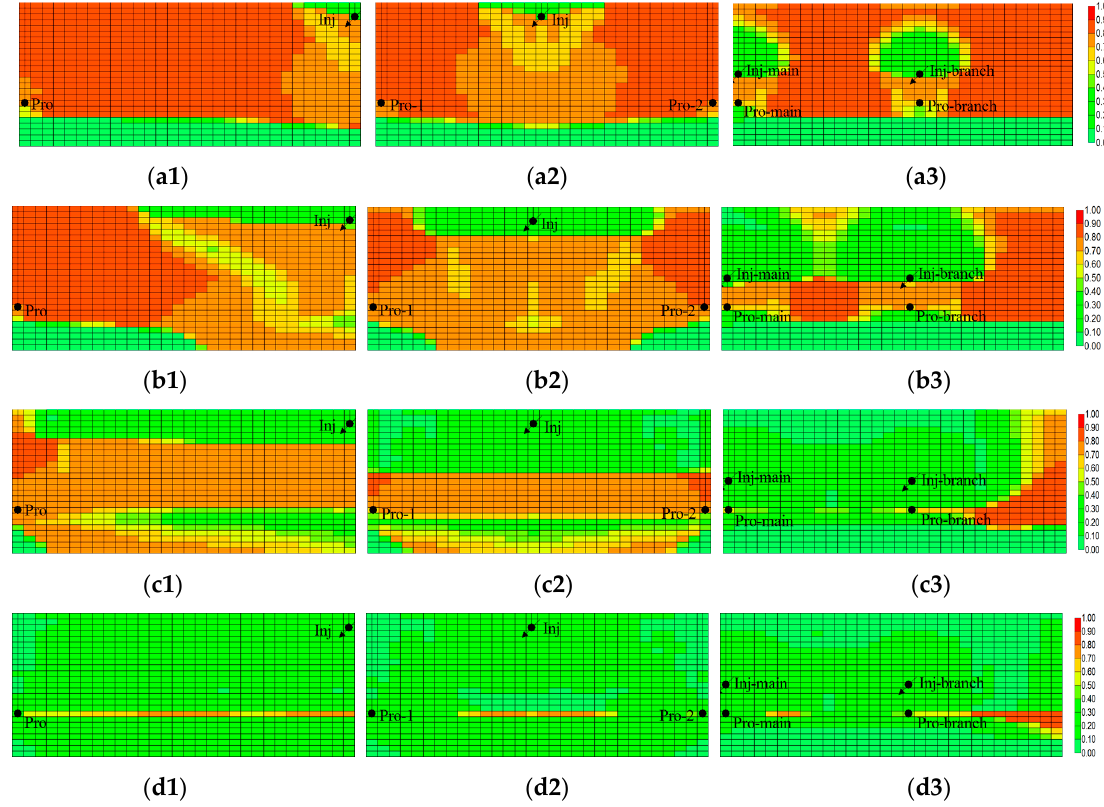
Figure 14. Oil saturation distribution (in the I-K direction cross-section) of ( 1 ) two corner wells, ( 2 ) triple wells, and ( 3 ) fishbone well at the end of different production times: ( a ) 0.5 years; ( b ) 1 year; ( c ) 2 years; and ( d ) 5 years.